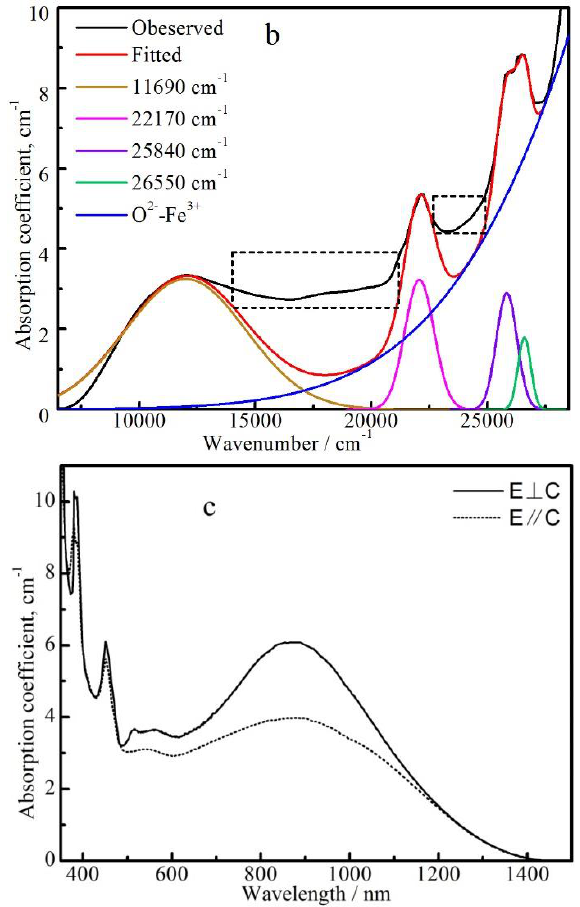
Figure 3. Optical absorption spectra of sapphire samples: ( a ) comparison of optical absorption spec-tra before and after reduction annealing; ( b ) fitting spectra of the optical absorption spectrum of sapphire after reduction annealing; ( c ) polarized absorption spectra of sapphire after reduction an- nealing. Table 2. Intensity and FWHM of absorption bands obtained by fitting.